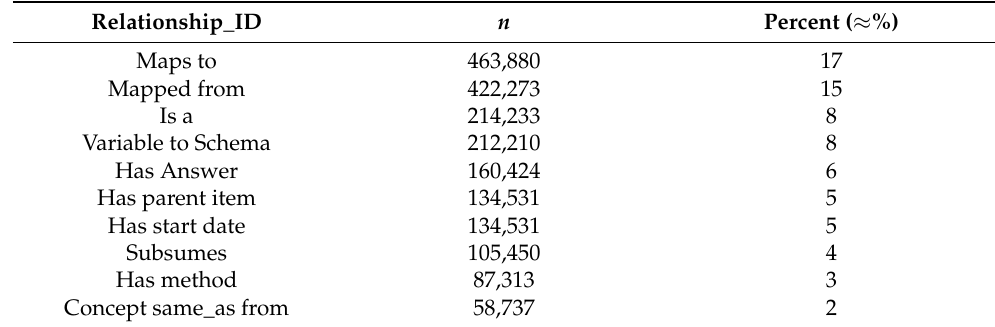
Table 2. Top 10 relations with number and percentage of connected